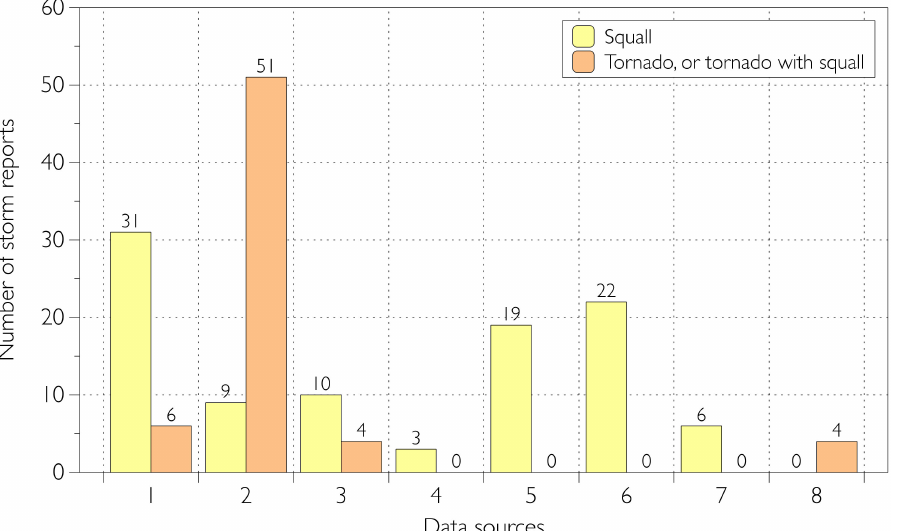
Figure 4. Number of storm events depending on the data sources: 1—damage reports only, 2—satellite images of windthrow only, 3—satellite images of windthrow and damage reports, 4—satellite images of windthrow and weather station reports, 5—weather station reports only, 6—weather station and damage reports, 7—satellite images of windthrow, weather station and damage report, 8—eyewitness reports